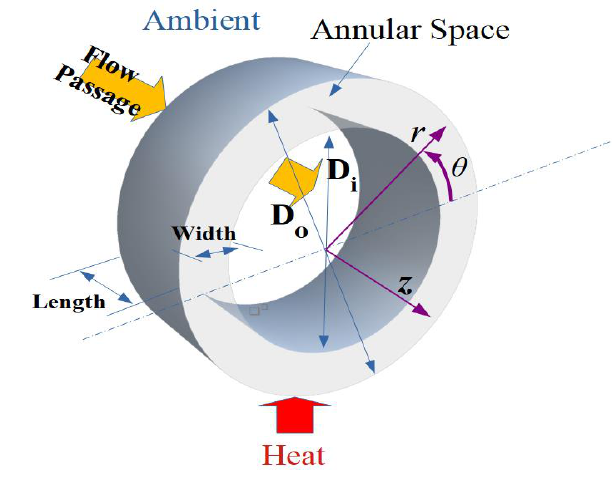
Figure 2. Concentric annular heat pipe model.